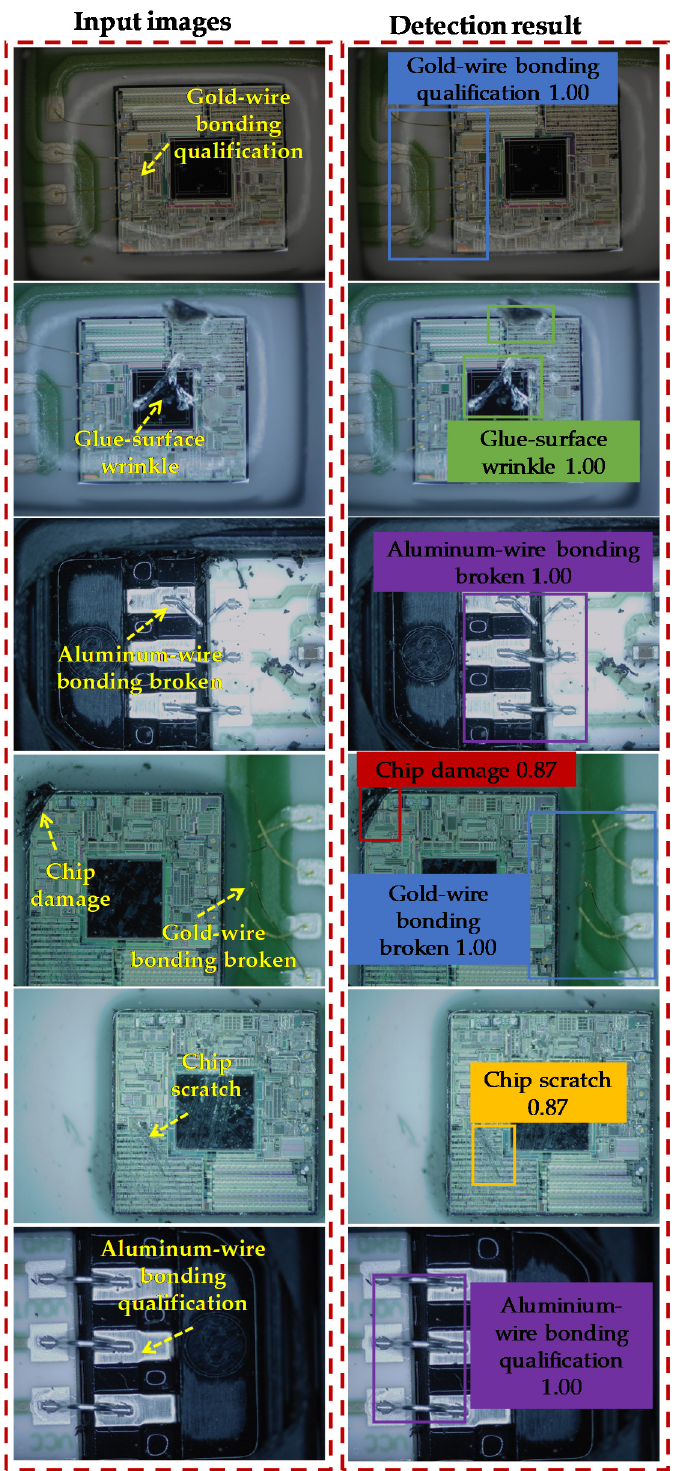
Figure 9. Defect-detection results of the MEMS pressure sensor based on the ADCNN. Average accuracy ( AP ) is used to evaluate the results of testing experiments. AP is a good trade-off between accuracy and recall, which are two important testing indexes. These indexes are defined as follows.